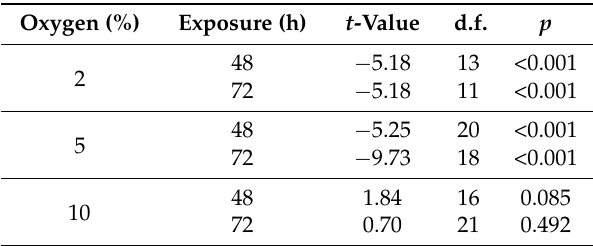
Table 2. Results of statistical comparisons between treatment groups and controls regarding the number of adults emerged from eggs laid by female cowpea bruchids. Hypoxia below 5% was sufficient to reduce eventual adult emergence relative to the controls. Oxygen (%) Exposure (h) t -Value d.f. p 48 ´ 5.18 13 <0.001 2 72 ´ 5.18 11 <0.001 48 ´ 5.25 20 <0.001 5 72 ´ 9.73 18 <0.001 48 1.84 16 0.085 10 72 0.70 21